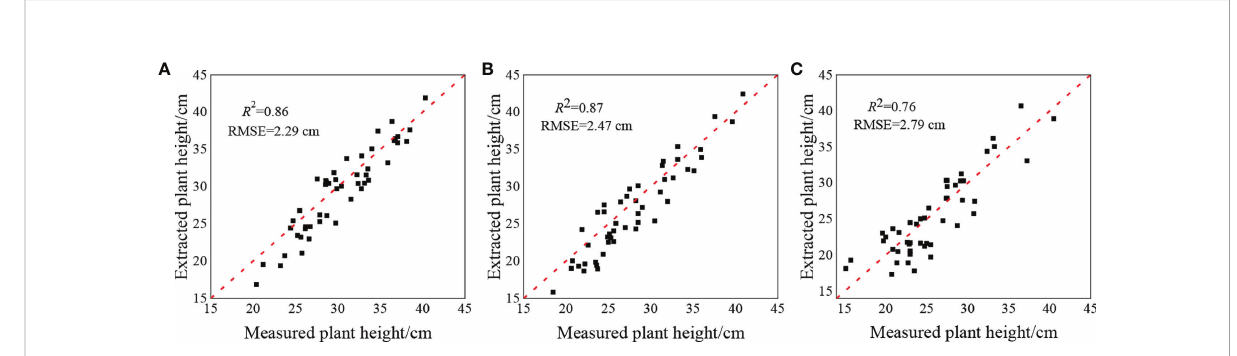
FIGURE 3 Contrastive analysis of plant height extracted from potato and measured plant height at (A) S1, (B) S2, (C)